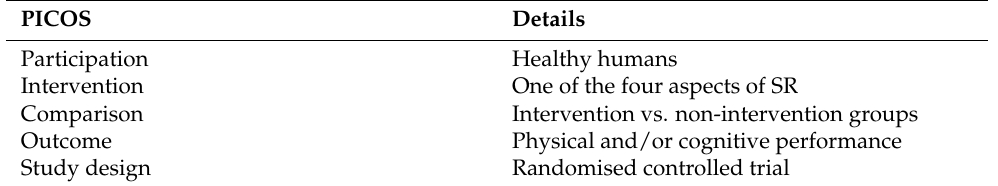
Table 1. The PICOS method for the eligibility criteria (participation, intervention, comparison, outcome, and study design). PICOS Details Participation Healthy humans Intervention One of the four aspects of SR Comparison Intervention vs. non-intervention groups Outcome Physical and/or cognitive performance Study design Randomised controlled